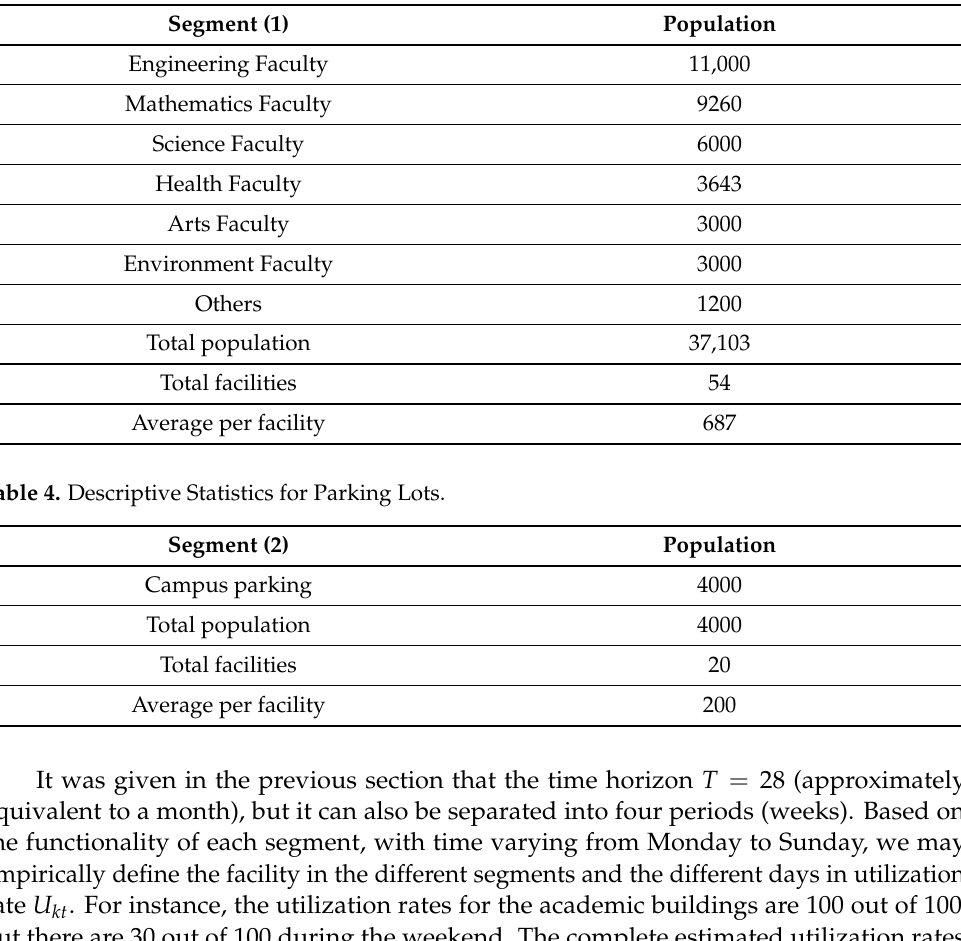
Figure 3. Coordinates for all facilities in the workspace. Table 3. Descriptive Statistics for Academic Buildings.